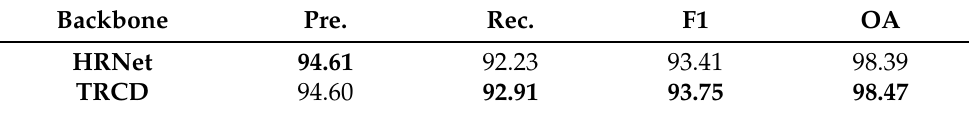
Table 9. Quantitative results of improved framework on CDD with 3000 pairs of images. Backbone Pre. Rec. F1 OA HRNet 94.61 92.23